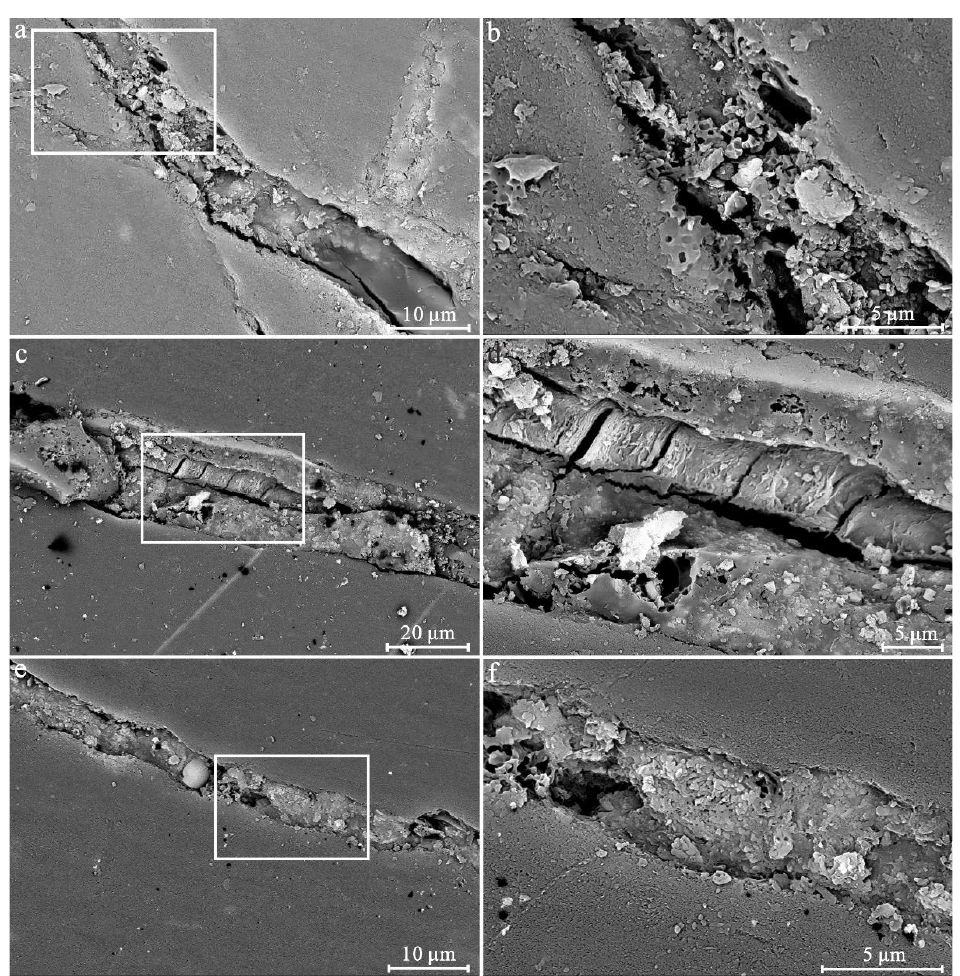
Figure 4. Occurrence of graphite microcrystals in graphitized coal samples under SEM. ( a ) graphite microcrystals as fracture-filling in sample CO1; ( b ) enlargement of rectangle in ( a ) with flowing and pore structure; ( c ) graphite microcrystals as fracture-filling in sample CO3; ( d ) enlargement of rectangle in ( c ) with several pore structure in the boundary of fracture; ( e ) graphite microcrystals as fracture-filling in sample CO1; ( f ) enlargement of rectangle in ( e ) with flake and flowing structure and several pores.